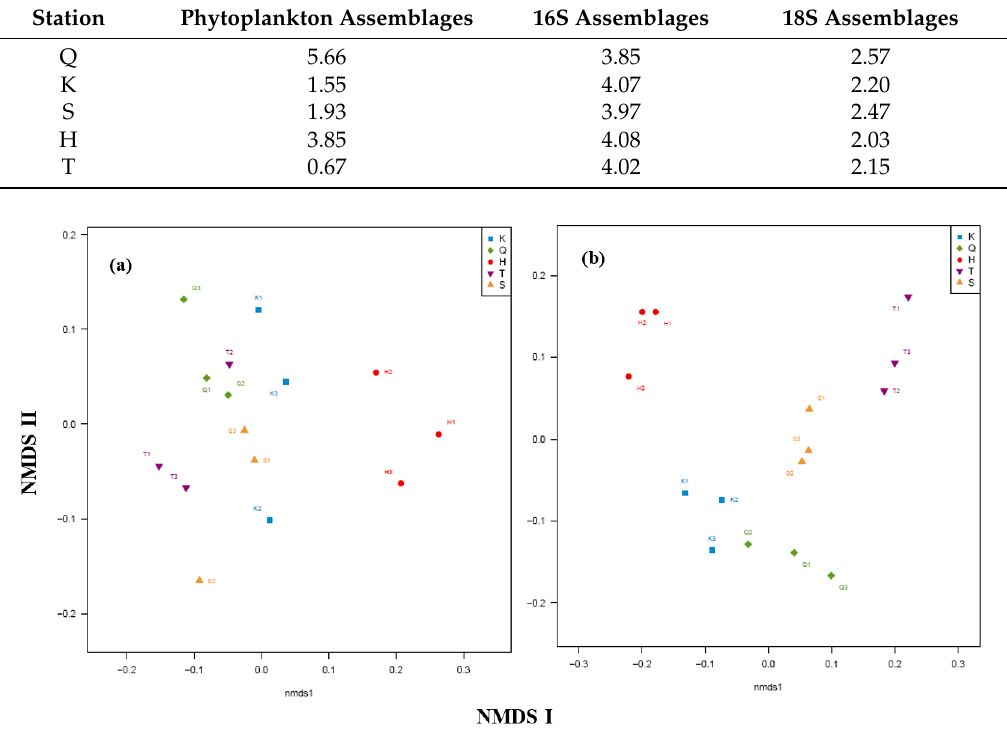
Figure A1. NMDS analysis of 16S ( a ) and 18S ( b ) assemblages structure. Station codes represented the first letter of their names: H: Heijizuo, K: Kuxin, Q: Qushou, S: Songgan, T: Taizishang. The numbers after the station codes indicated the repeating serial numbers.